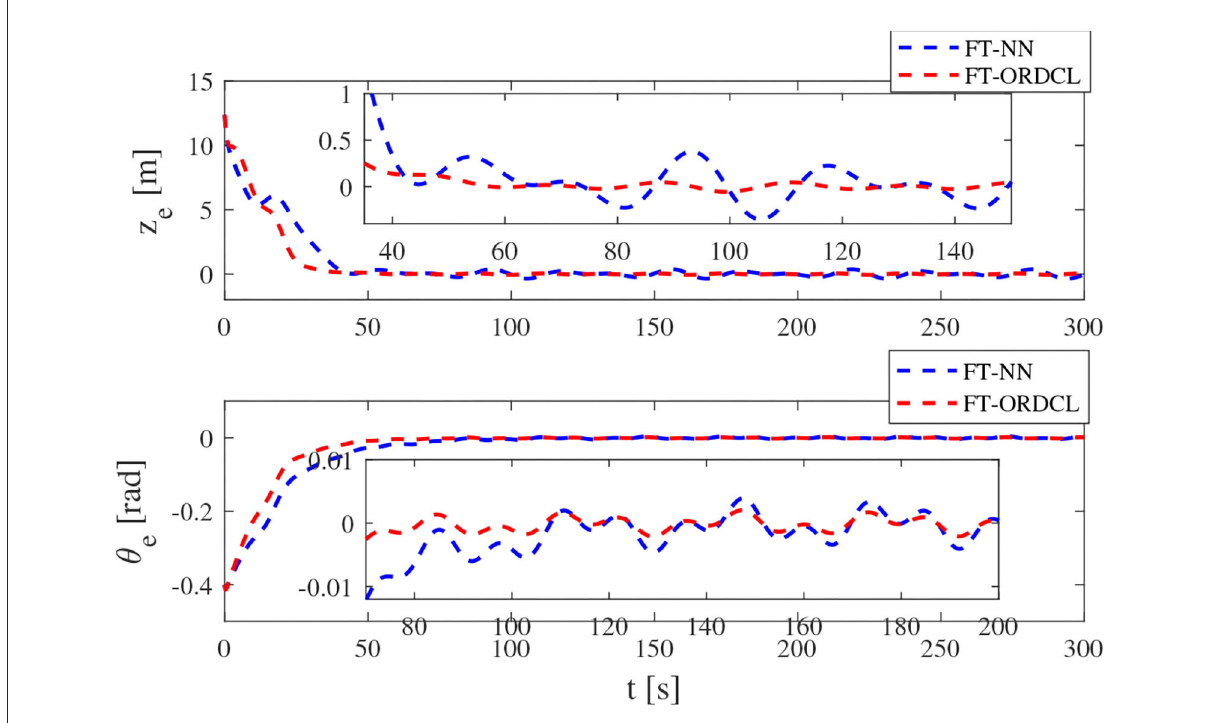
FIGURE8 Tracking position error and yaw angle error in Case 2.